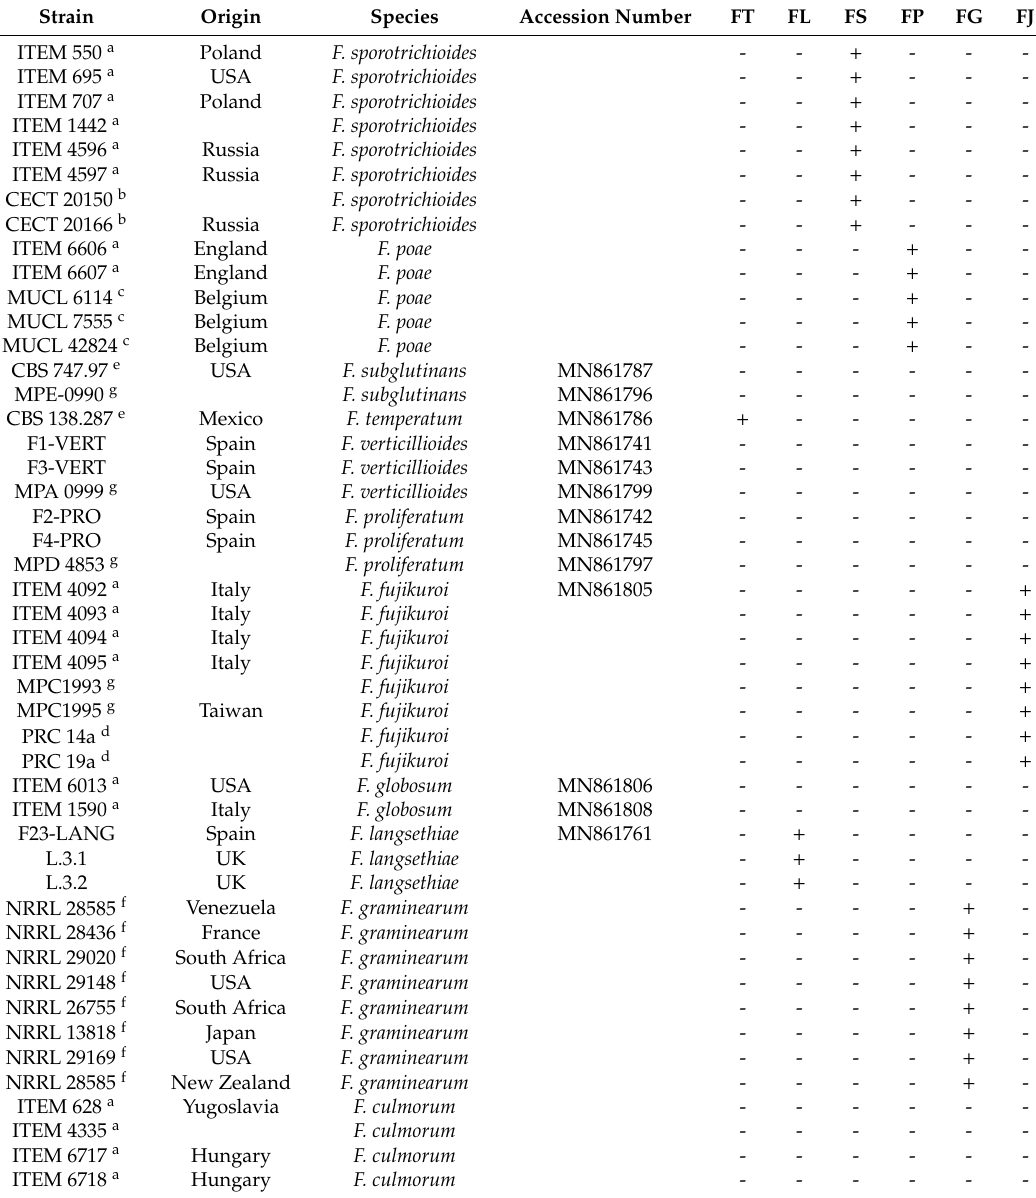
Table 2. Fungal strains analyzed indicating the origin, species, accession number, and presence ( + ) or absence (-) of the specific PCR amplification product of F. temperatum (FT), F. langsethiae (FL) F. sporotrichioides (FS), F. poae (FP), F. graminearum (FG), and F. fujikuroi (FJ) using the specific protocols designed in this